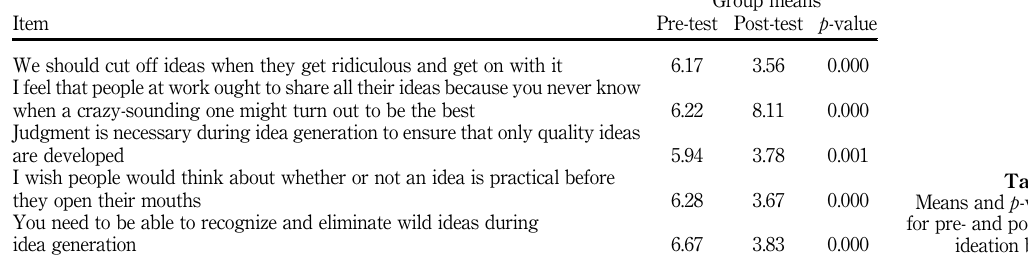
Table I. Means and p -values